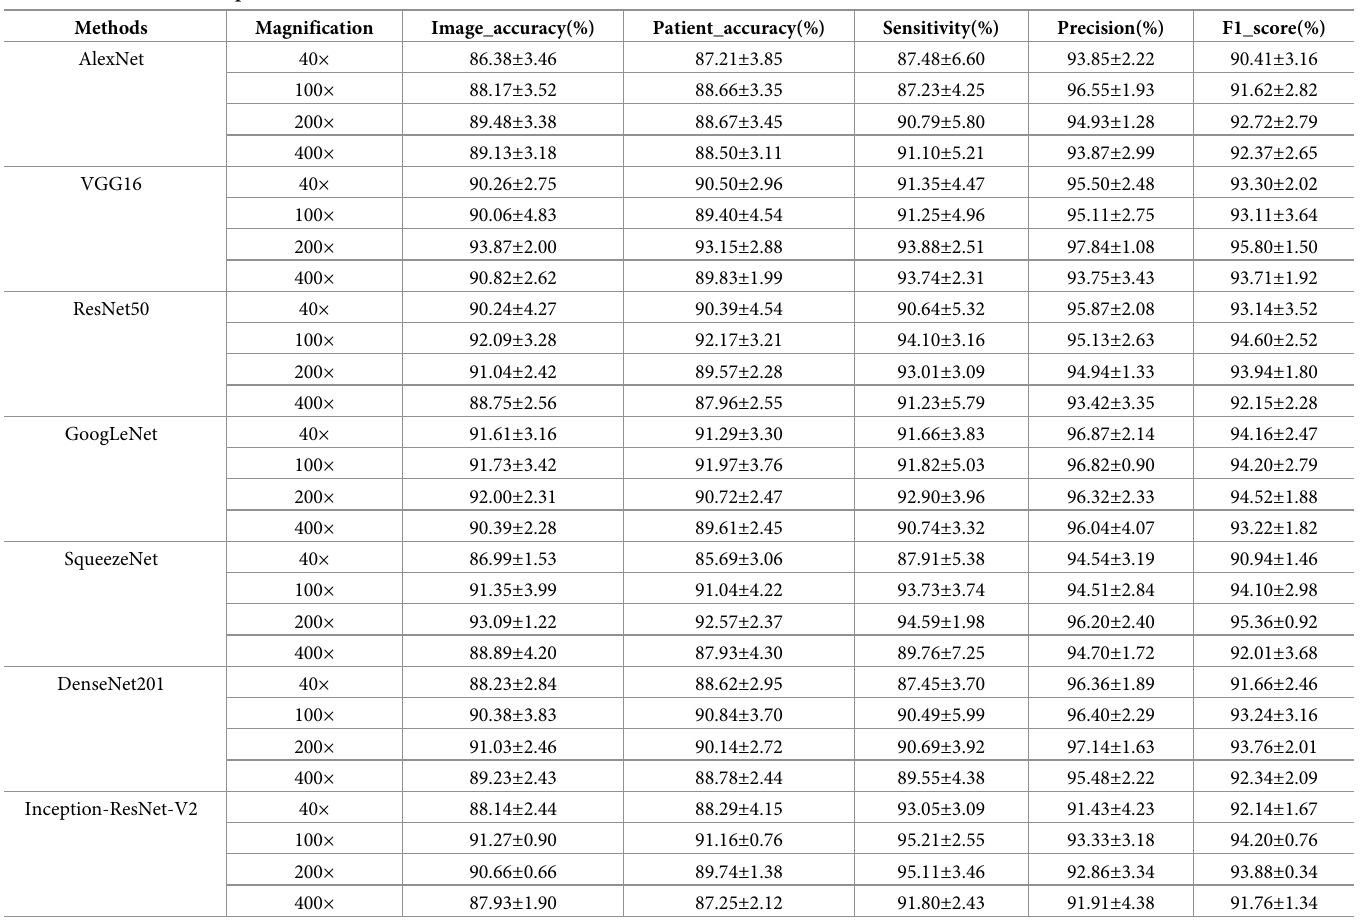
Table 4. MSB classification performance of baseline models.